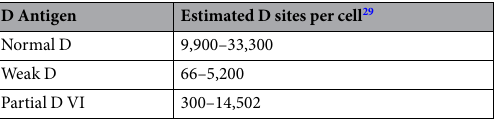
Table 1. Number of estimated D antigen binding sites per red blood cell 29